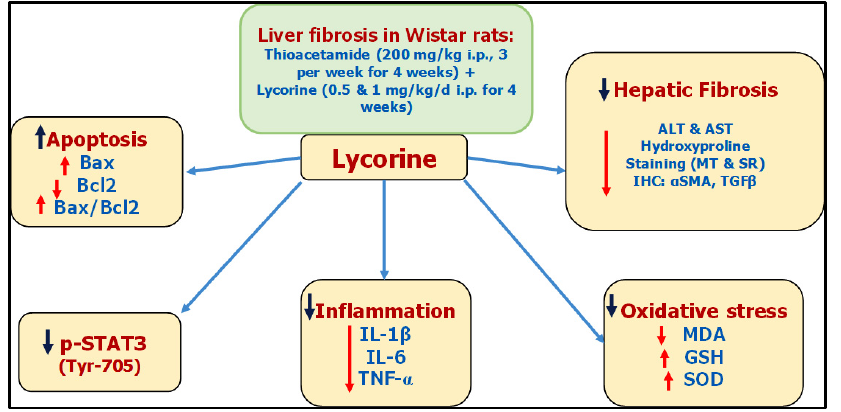
Figure 9. A collective diagram of lycorine antifibrotic effects against TAA-induced hepatic fibrosis in rats.